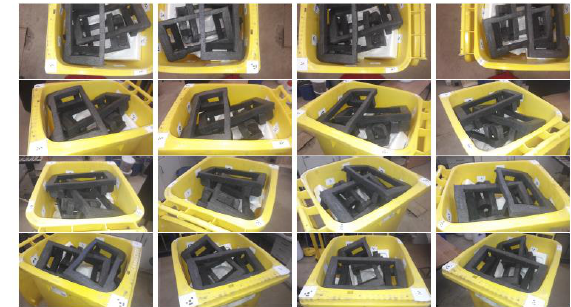
Figure 3: Gallery of 16 smartphone images of the nearly filled waste bin, ready for further photogrammetric processing